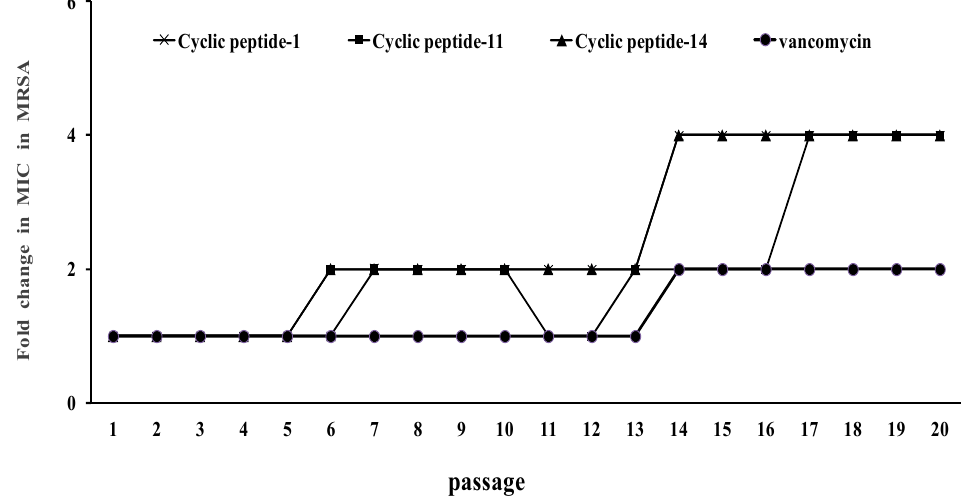
Figure 5. Resistance development of cyclic peptide-1, cyclic peptide-11, and cyclic peptide-14.